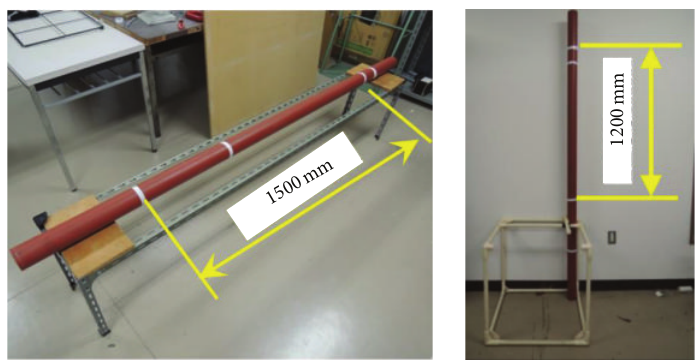
Figure 10: Experimental setup for testing robot movement.